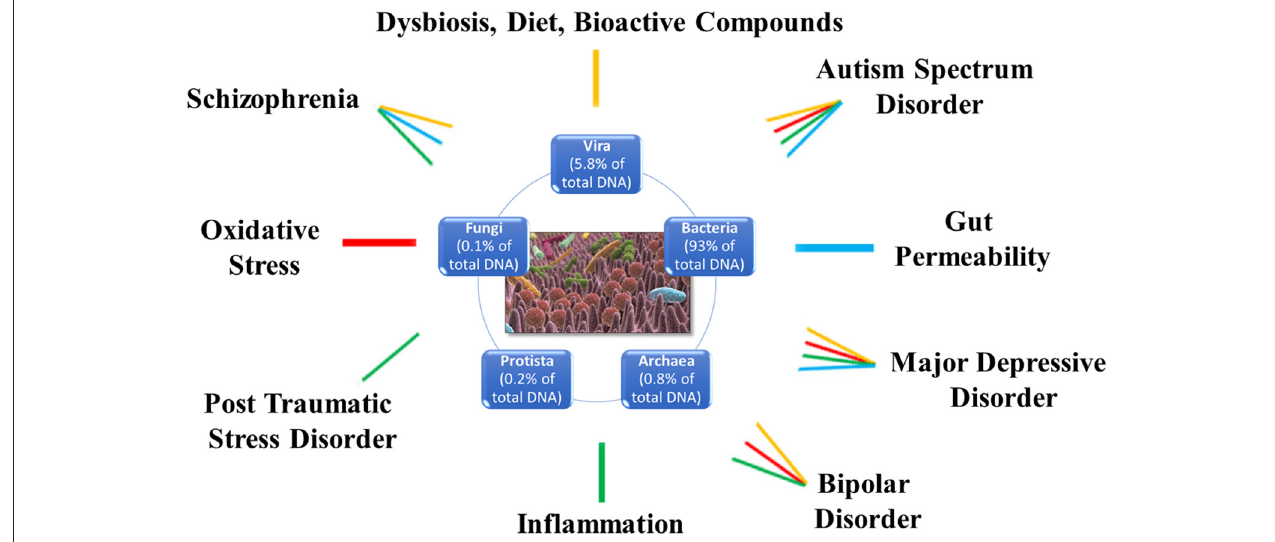
FIGURE 2 | Schematic representation of the different molecular pathways linking the microbiota with different psychiatric diseases including major depressive disorder. Each pathology is associated to specific altered biological processes: major depressive disorder and autism spectrum disorder are associated to dysbiosis, and alterations in diet and bioactive compounds (yellow), oxidative stress (red), inflammation (green), and gut permeability (light blue); schizophrenia is associated to dysbiosis, and alterations in diet and bioactive compounds (yellow), inflammation (green), and gut permeability (light blue); bipolar disorder is associated to dysbiosis, and alterations in diet and bioactive compounds (yellow), inflammation (green), and oxidative stress (red); post-traumatic stress disorder is associated to inflammation (green).